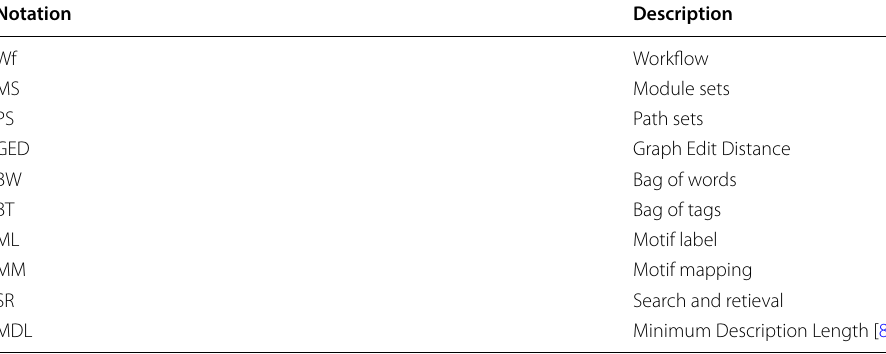
Table 2 Algorithm shorthand notation